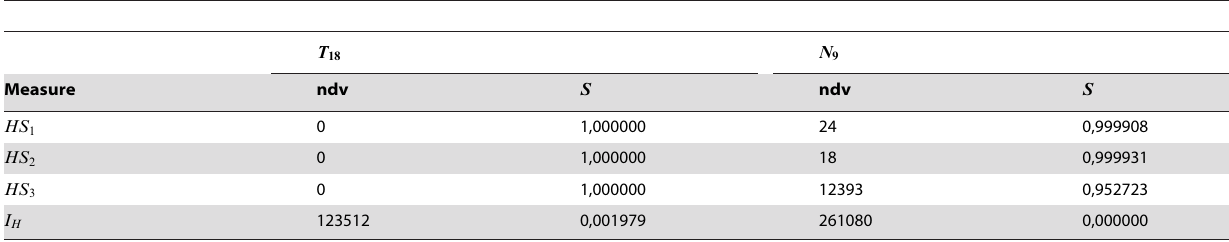
Table 3. Exhaustively generated sets of non-isomorphic trees and graphs: D T 18 D ~ 123757 , D N 9 D ~ 261080